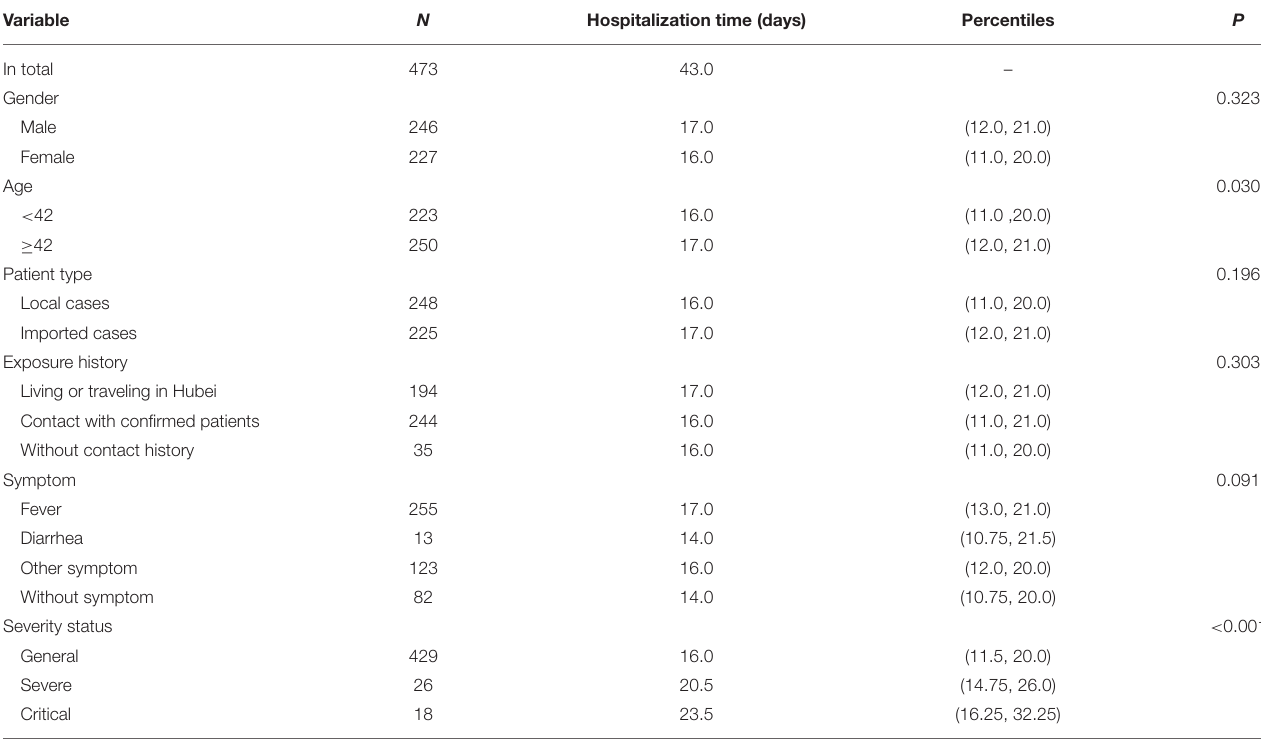
TABLE 3 | Clinical outcomes of COVID-19 patients.